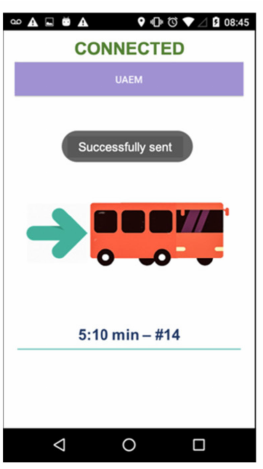
Figure 16. Interface for the bus